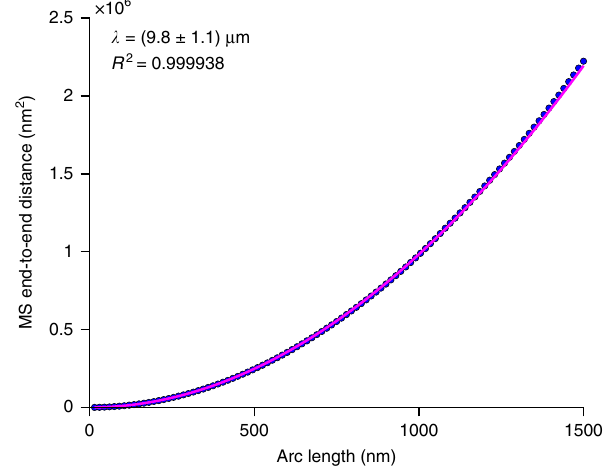
Fig. 4 Persistence length of nanorods. Mean-squared (MS) end-to-end distance of nanorods as a function of their inner contour length in 100 bins (blue dots). Data was collected from AFM images of nanorods deposited on mica and graphite from aqueous solutions after NH 4 OH vapor diffusion. The magenta line represents the fi t of the data to Eq. (1), which is used to determine the persistence length ( λ ) (mean ± SD; N =